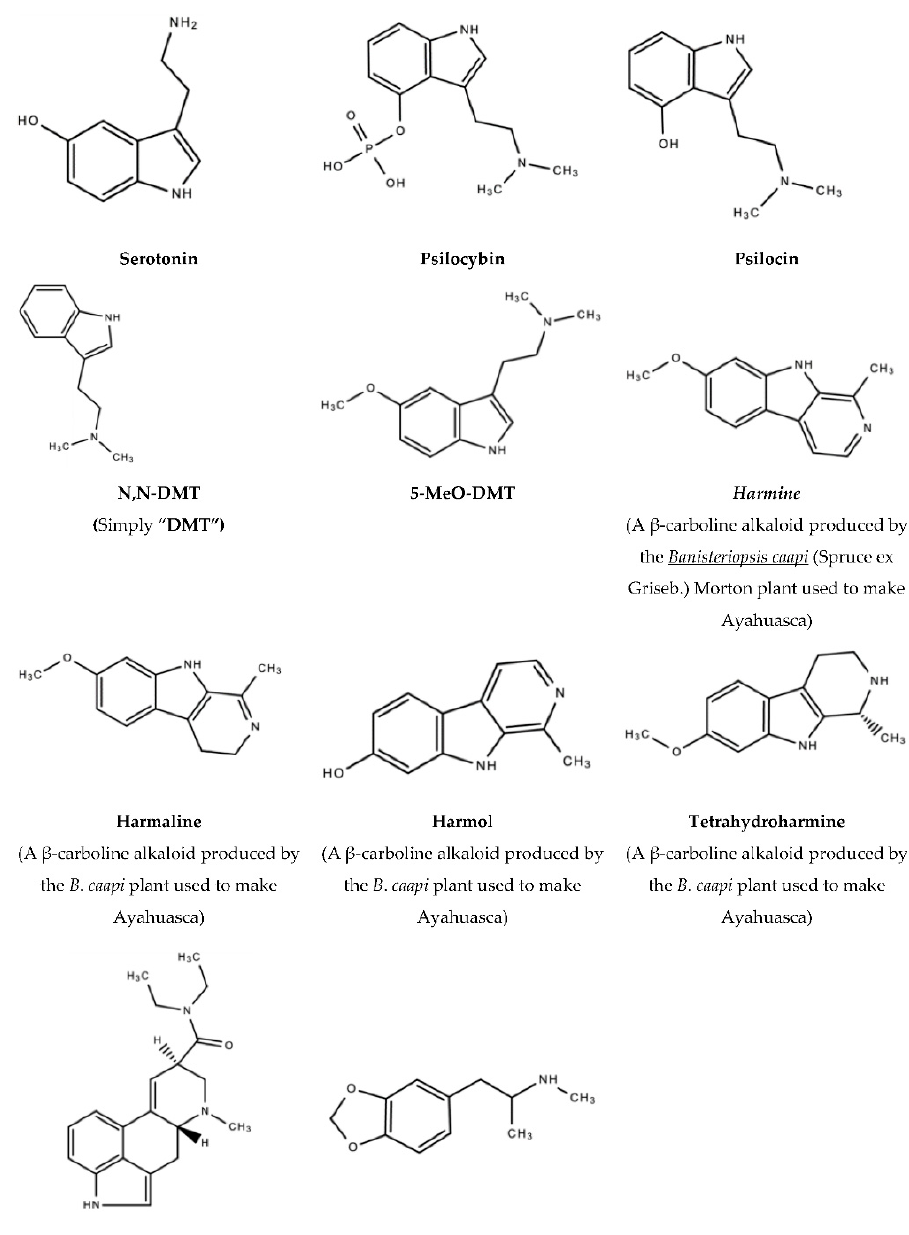
Figure 2. Serotonin, psychedelic drugs and derivatives of psychedelic drugs with therapeutic potential.